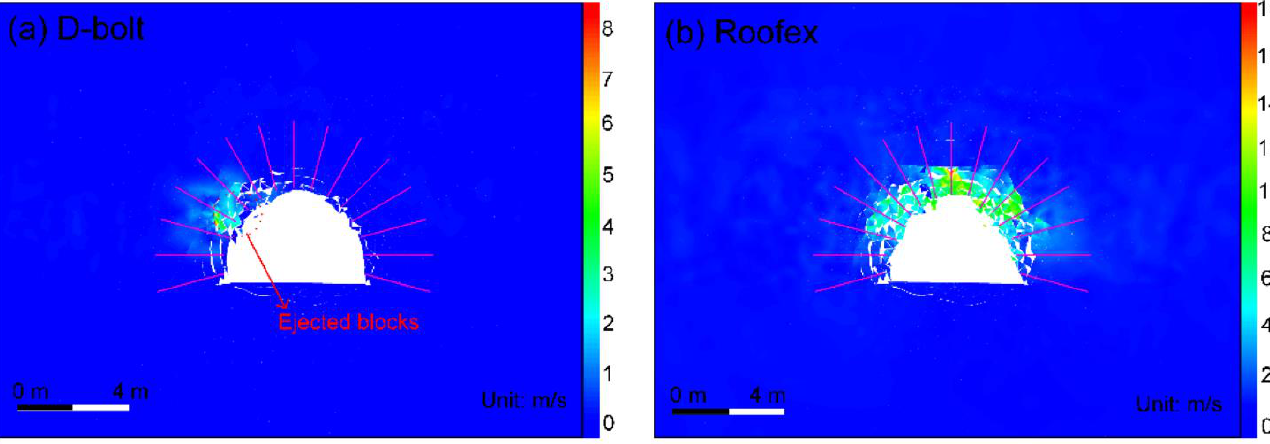
Figure 17. Simulated velocity distribution of the ejected rock mass along the tunnel supported by different types of rock bolt [88].